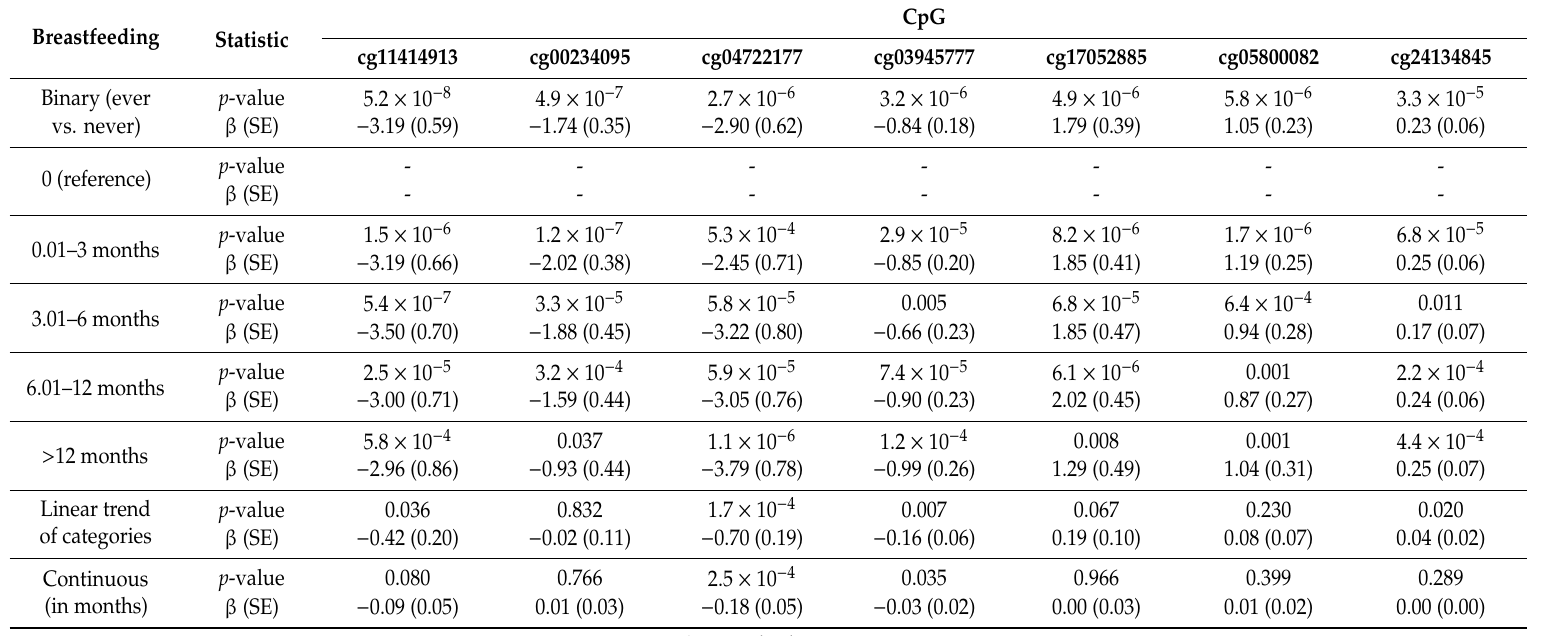
Table 2. Average percent point di ff erences ( β ) in DNA methylation at age 7 (N = 640) according to breastfeeding.